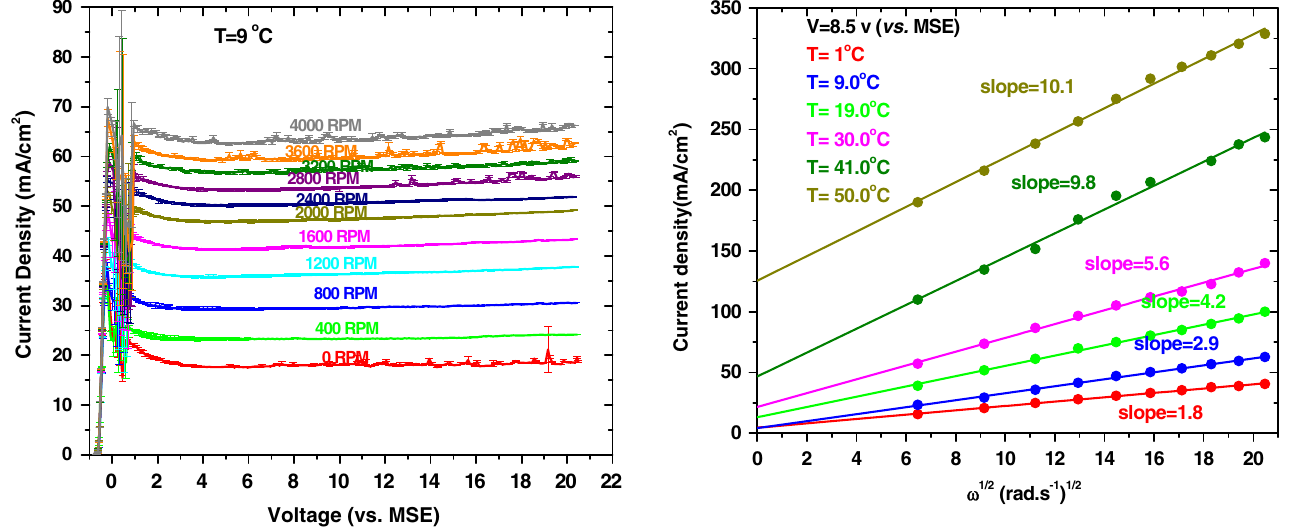
SO plotted as a function of the 2 4